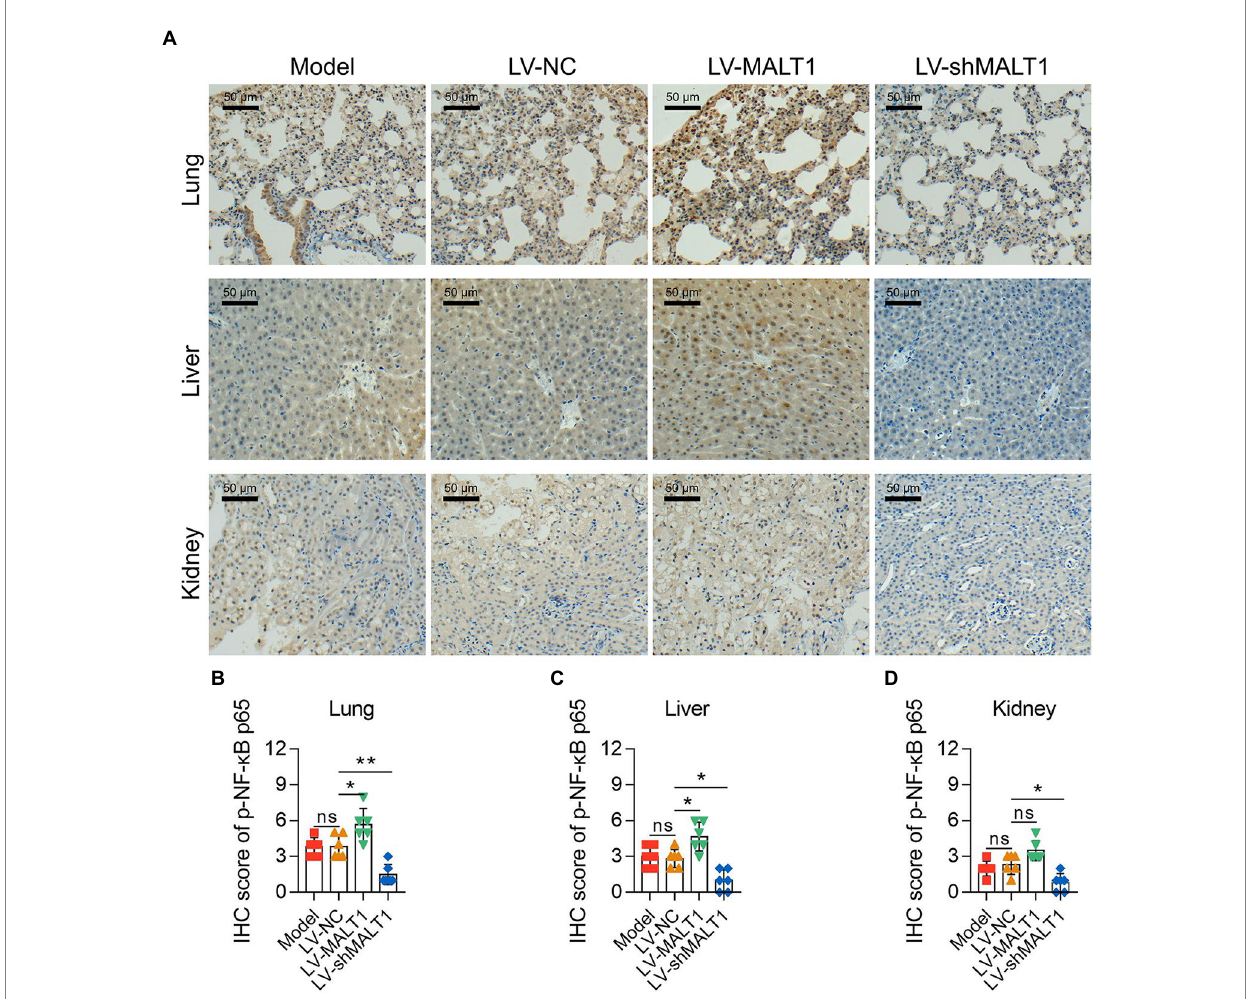
FIGURE 7 Effect of MALT1 on the NF- κ B pathway in LPS-induced septic mouse model. IHC analysis of p-NF- κ B p65 in lung, liver, and kidney tissues among the Model, LV-NC, LV-MALT1, and LV-shMALT1 groups (A) . Comparison of p-NF- κ B p65 IHC scores in the lung (B) , liver (C) , and kidney (D) among the Model, LV-NC, LV-MALT1, and LV-shMALT1 groups. n = 6 in each group. One-way ANOVA plus Tukey’s post hoc test was applied. Ns, not significant; * p < 0.05; ** p <